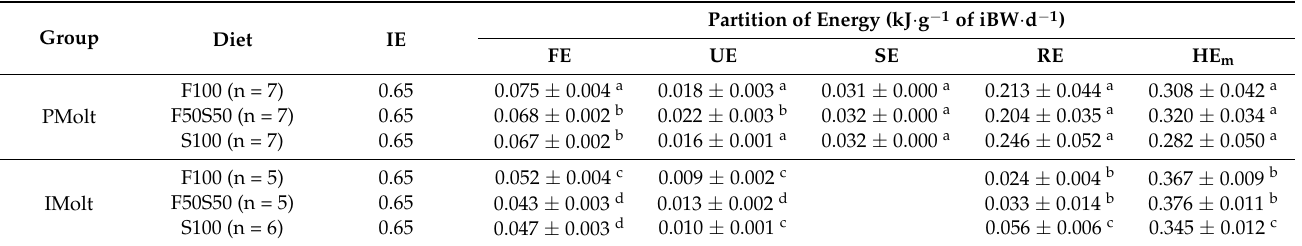
Table 6. Adjusted mean values of energy budgets, for PMolt and IMolt crabs, fed on 3 different experimental